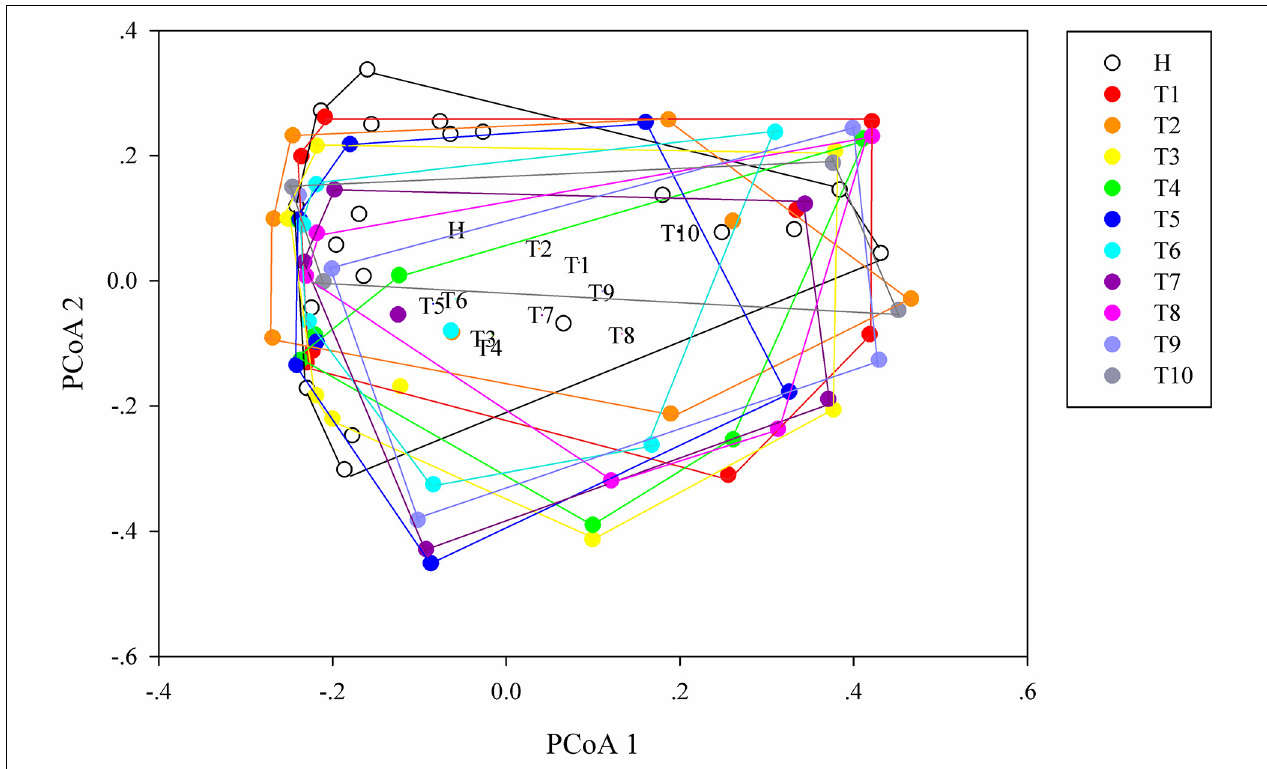
FIGURE 3 | Microbial biomarkers among healthy individuals (H) and NLCLC patients (before the first therapy T1 and before the tenth therapy T10). Significantly different abundant taxa as biomarkers using Kruskal–Wallis test ( P < 0.05) with LDA score > 2.0. based on LEfSe analysis.